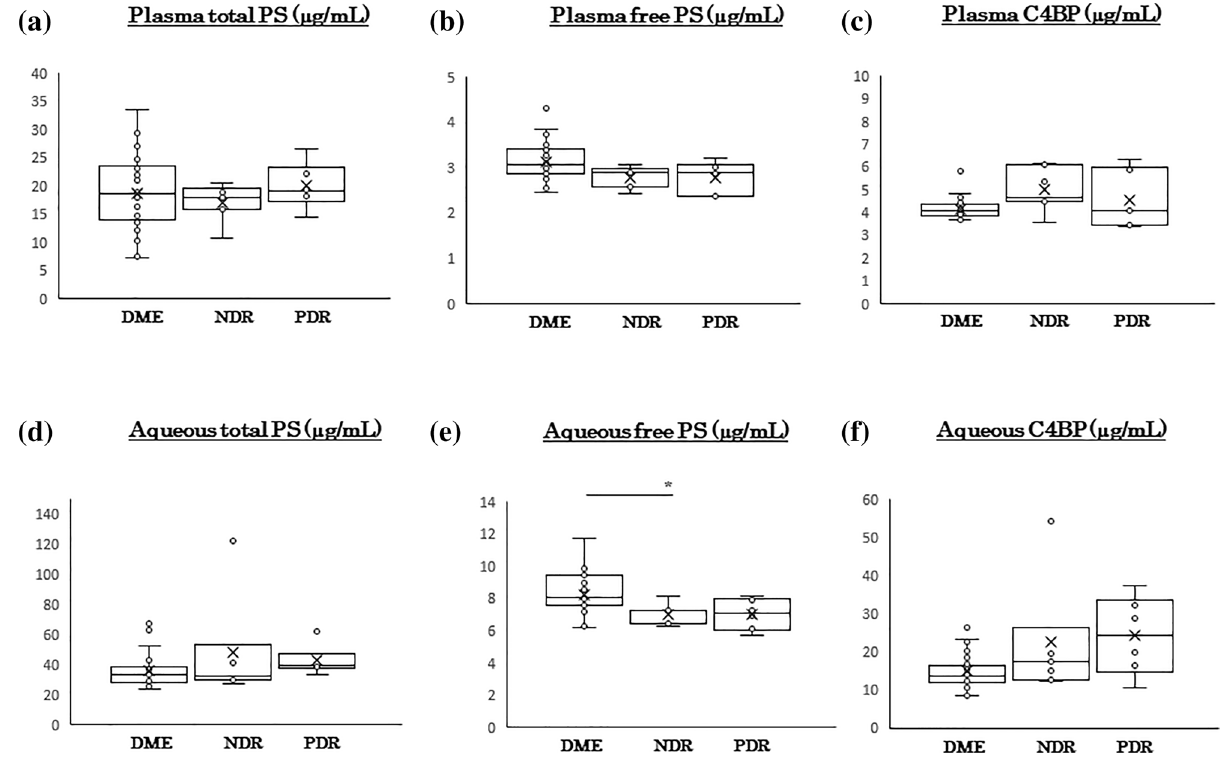
Figure 2. Plasma and aqueous humor concentrations of protein S and related molecules in patients with diabetic retinopathy (DR). The plasma levels of total PS ( a ), free PS ( b ), and C4BP ( c ) are not significantly different among the different groups. The aqueous humor levels of total PS and C4BP are also not significantly different ( d , f ). The aqueous humor level of free PS is significantly higher in the DME group than the other